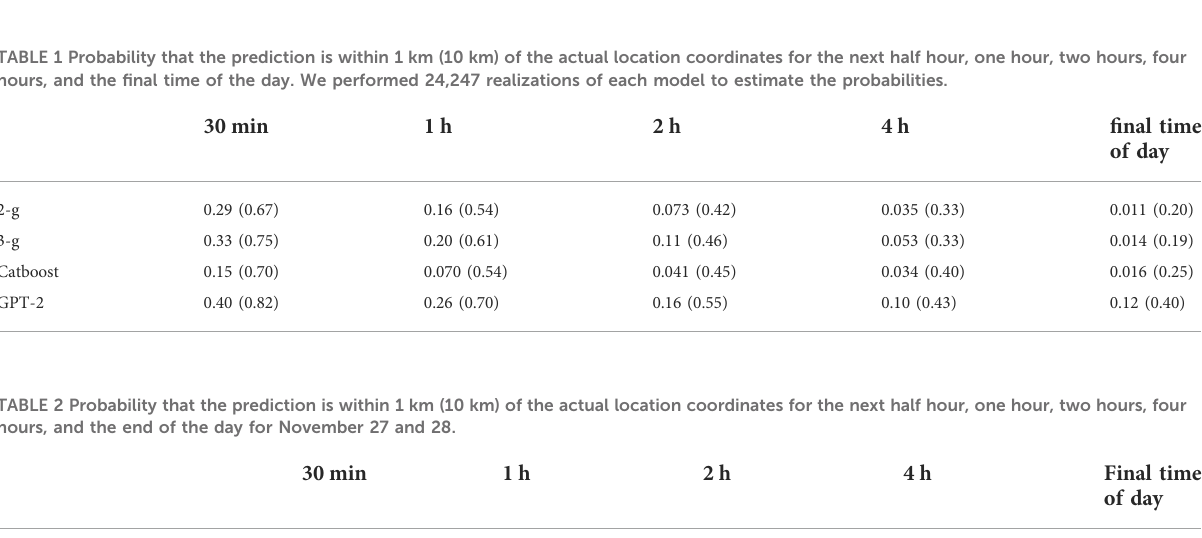
FIGURE 7 People ’ s diffusion for ( □ ) original trajectory and trajectories generated by ( ▲ ) 2-g, ( ▼ ) 3-g, ( Horizontal axis indicates the elapsed time from the initial time. Vertical axis represents the mean square of the distance from the initial location. The dotted and dashed guidelines show that the mean square of the distance is proportional to the elapsed time and the square of the elapsed time, respectively. The four plots for the initial 2 h on the left side are initial values of the models.